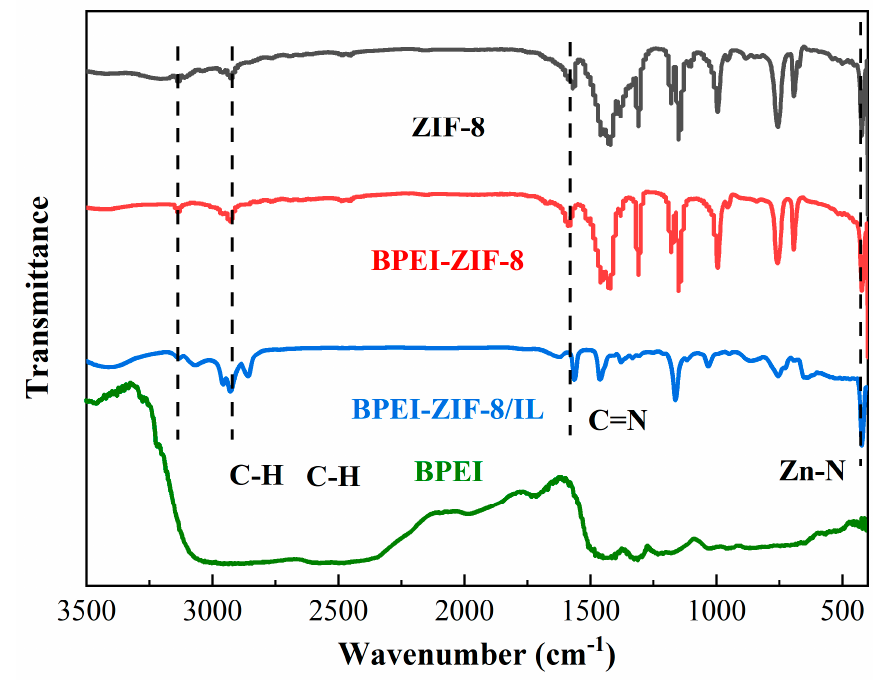
Figure 2. FTIR spectra of ZIF-8, BPEI, BPEI-ZIF-8, and BPEI-ZIF-8/IL.